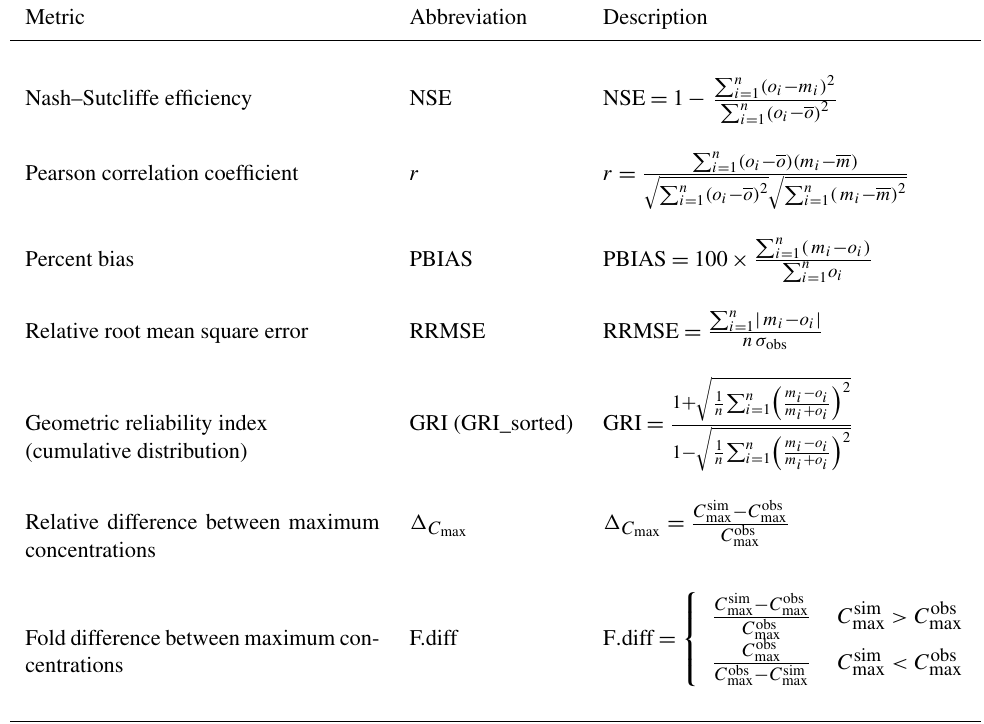
Table 3. Metrics used for quantifying model performance. C obs max : observed maximum concentration, C sim max : simulated maximum concen- tration, m i : model prediction i , m : mean model prediction, n : number of observations, o i : observation i , o : mean of the observations, σ obs : standard deviation of the